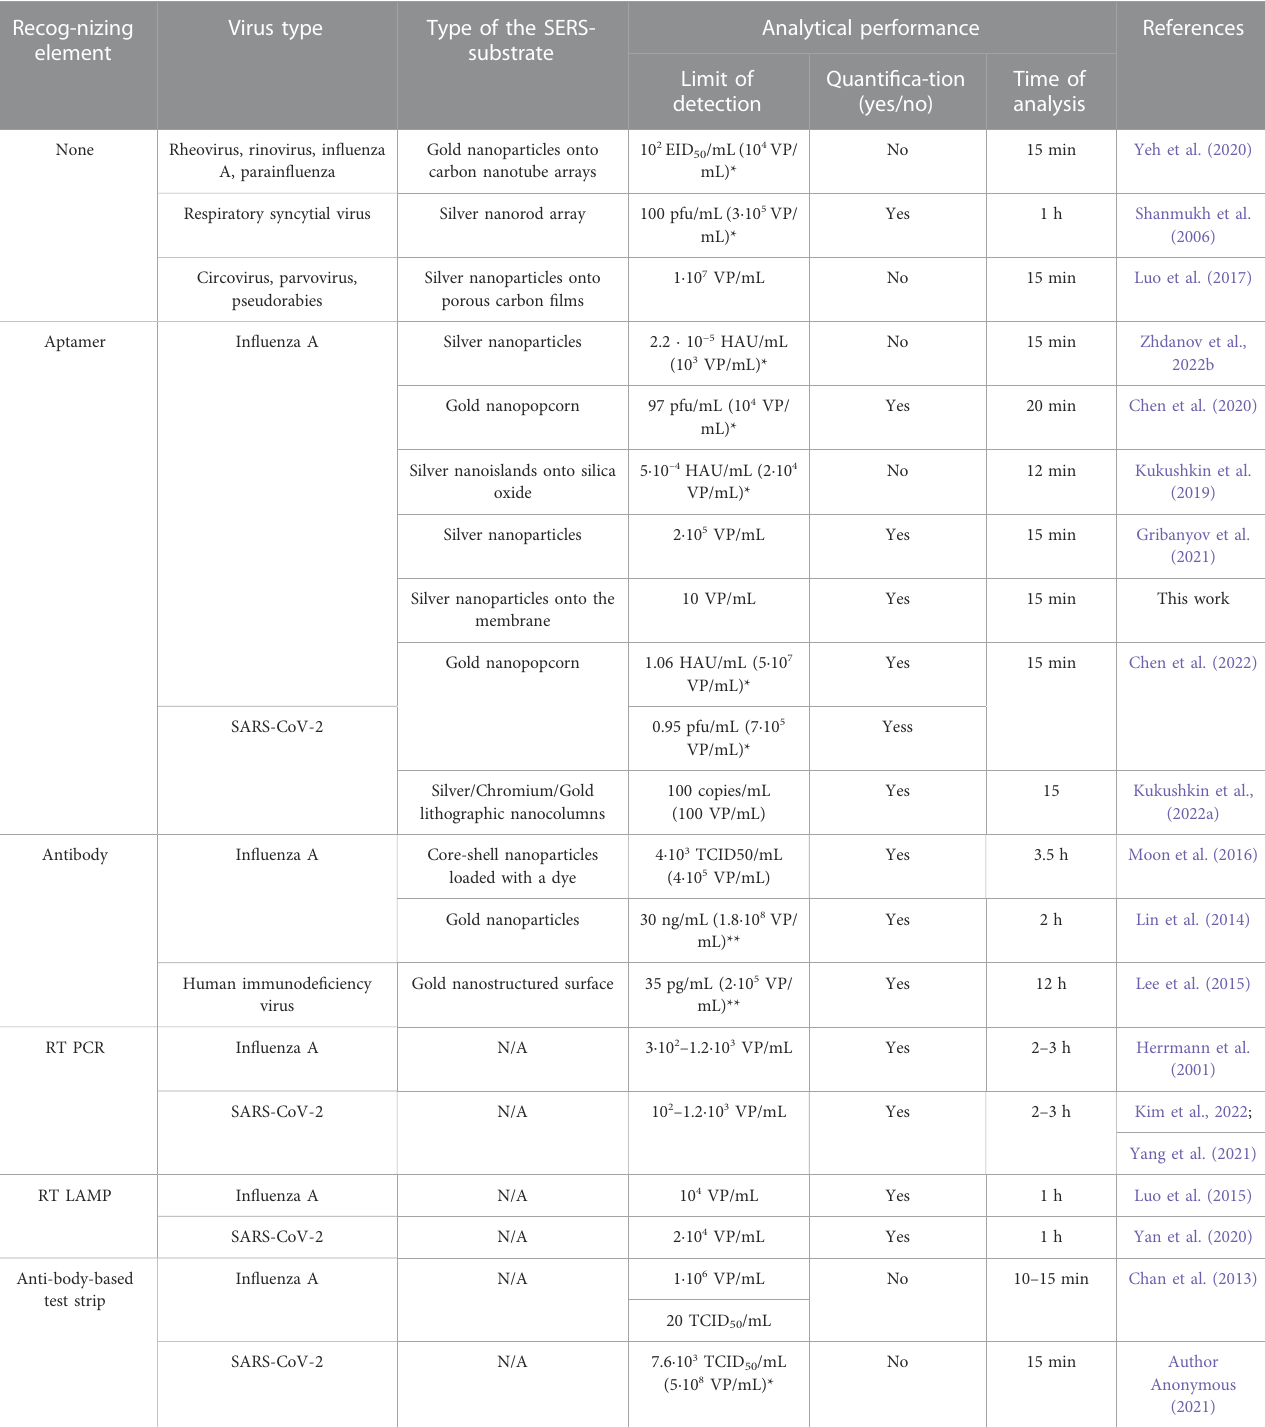
TABLE 1 Comparison of SERS or SEF-based sensors for the detection of viral particles with conventional diagnostic assays. N/A – not applicable, RT PCR – reverse transcription polymerase chain reaction, RT LAMP – reverse transcription loop-mediated isothermal ampli fi cation. * the recalculation was performed using the ratios from the refs. (Kramberger et al., 2012; Klimstra et al., 2020; McCormick and Mermel, 2021), **molecular weight of the in fl uenza virus was approximated as 10 7 Da. Recog-nizing